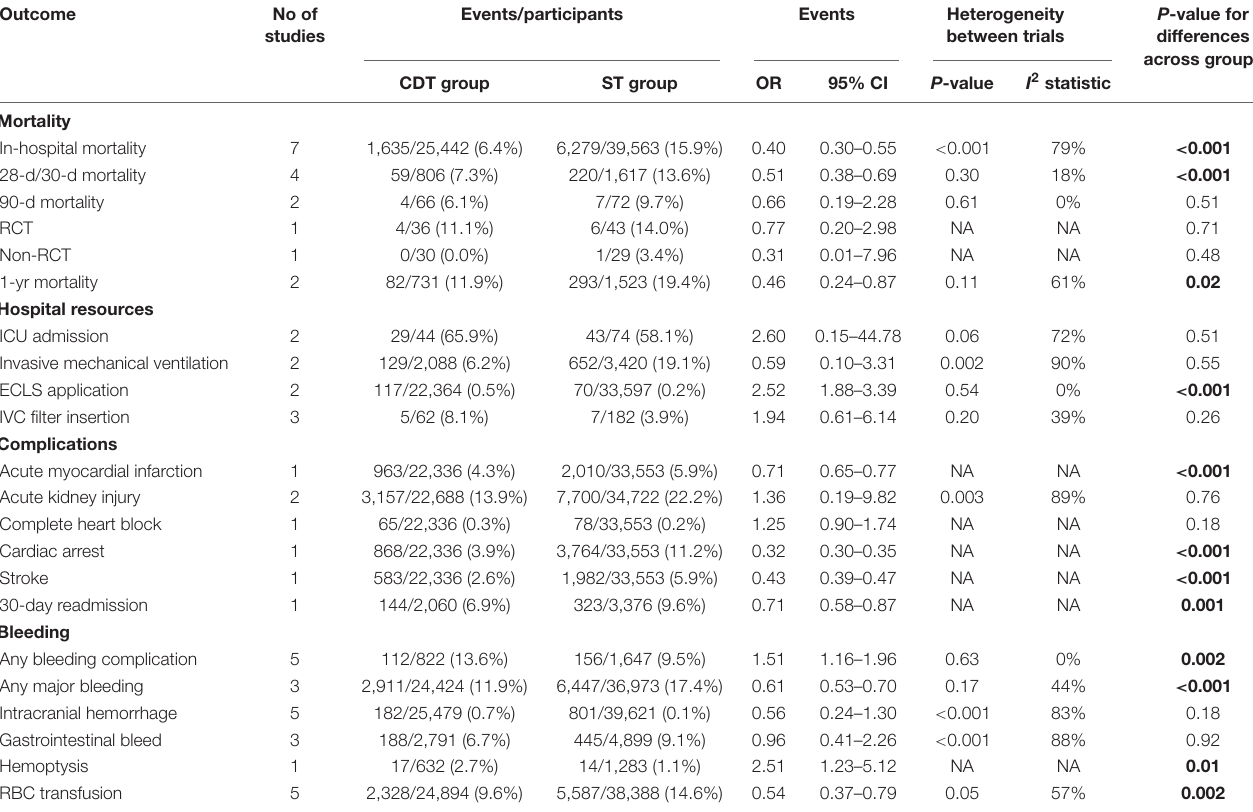
P -value for between trials differences across groups